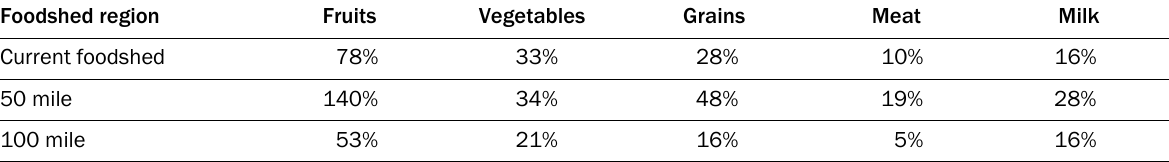
Table 9. Proportion of Food Produced in the Three Foodsheds That Is Consumed by Philadelphia* Foodshed region Fruits